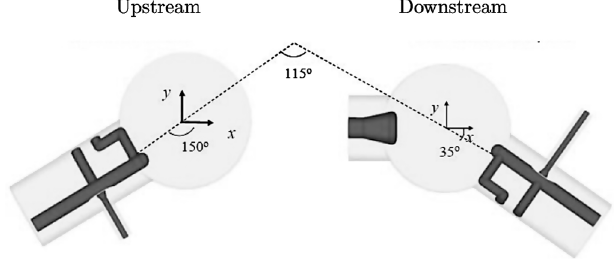
FIG. 3. Geometry and orientation of the higher order mode (HOM, upstream, and downstream) and fundamental power coupler (FPC, downstream).